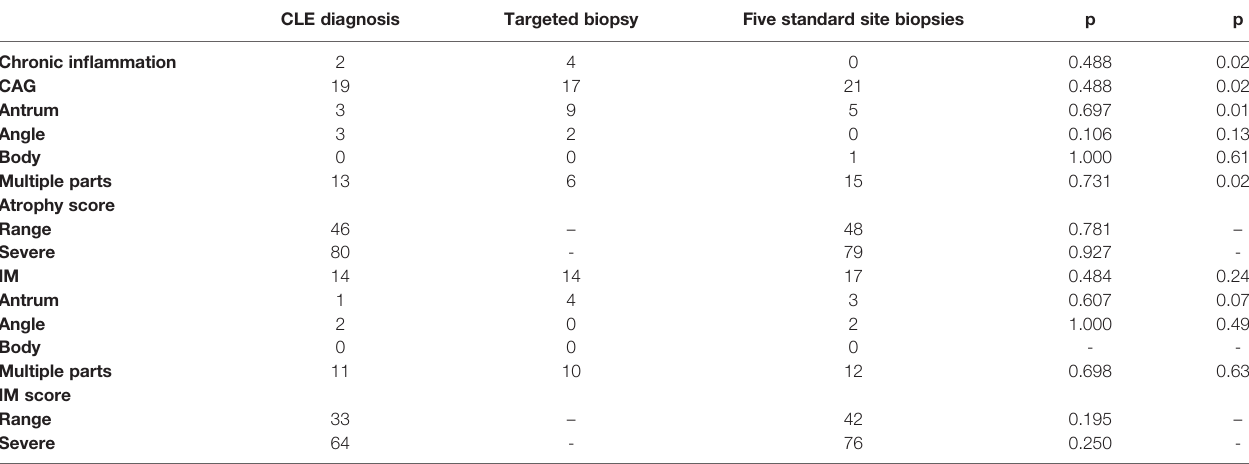
TABLE 2 | The diagnosis results of CLE image diagnosis, CLE targeted biopsies, and fi ve-point standard